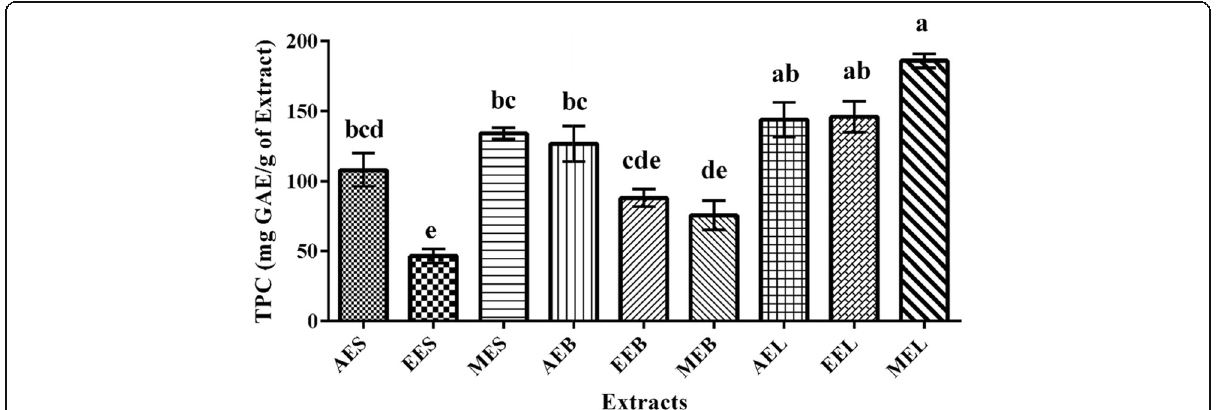
Fig. 1 Total phenolic content expressed as mg GAE (gallic acid equivalent)/g of extract in different extracts of B. orellana . Bars with different letters are significantly different according to Tukey ’ s HSD tests ( P < 0.05). TPC = total phenolic content; AES = aqueous extract (seed); EES = ethanolic extract (seed); MES = methanolic extract (seed); AEB = aqueous extract (branch); EEB = ethanolic extract (branch); MEB = methanolic extract (branch); AEL = aqueous extract (leaf); EEL = ethanolic extract (Leaf); MEL = methanolic extract